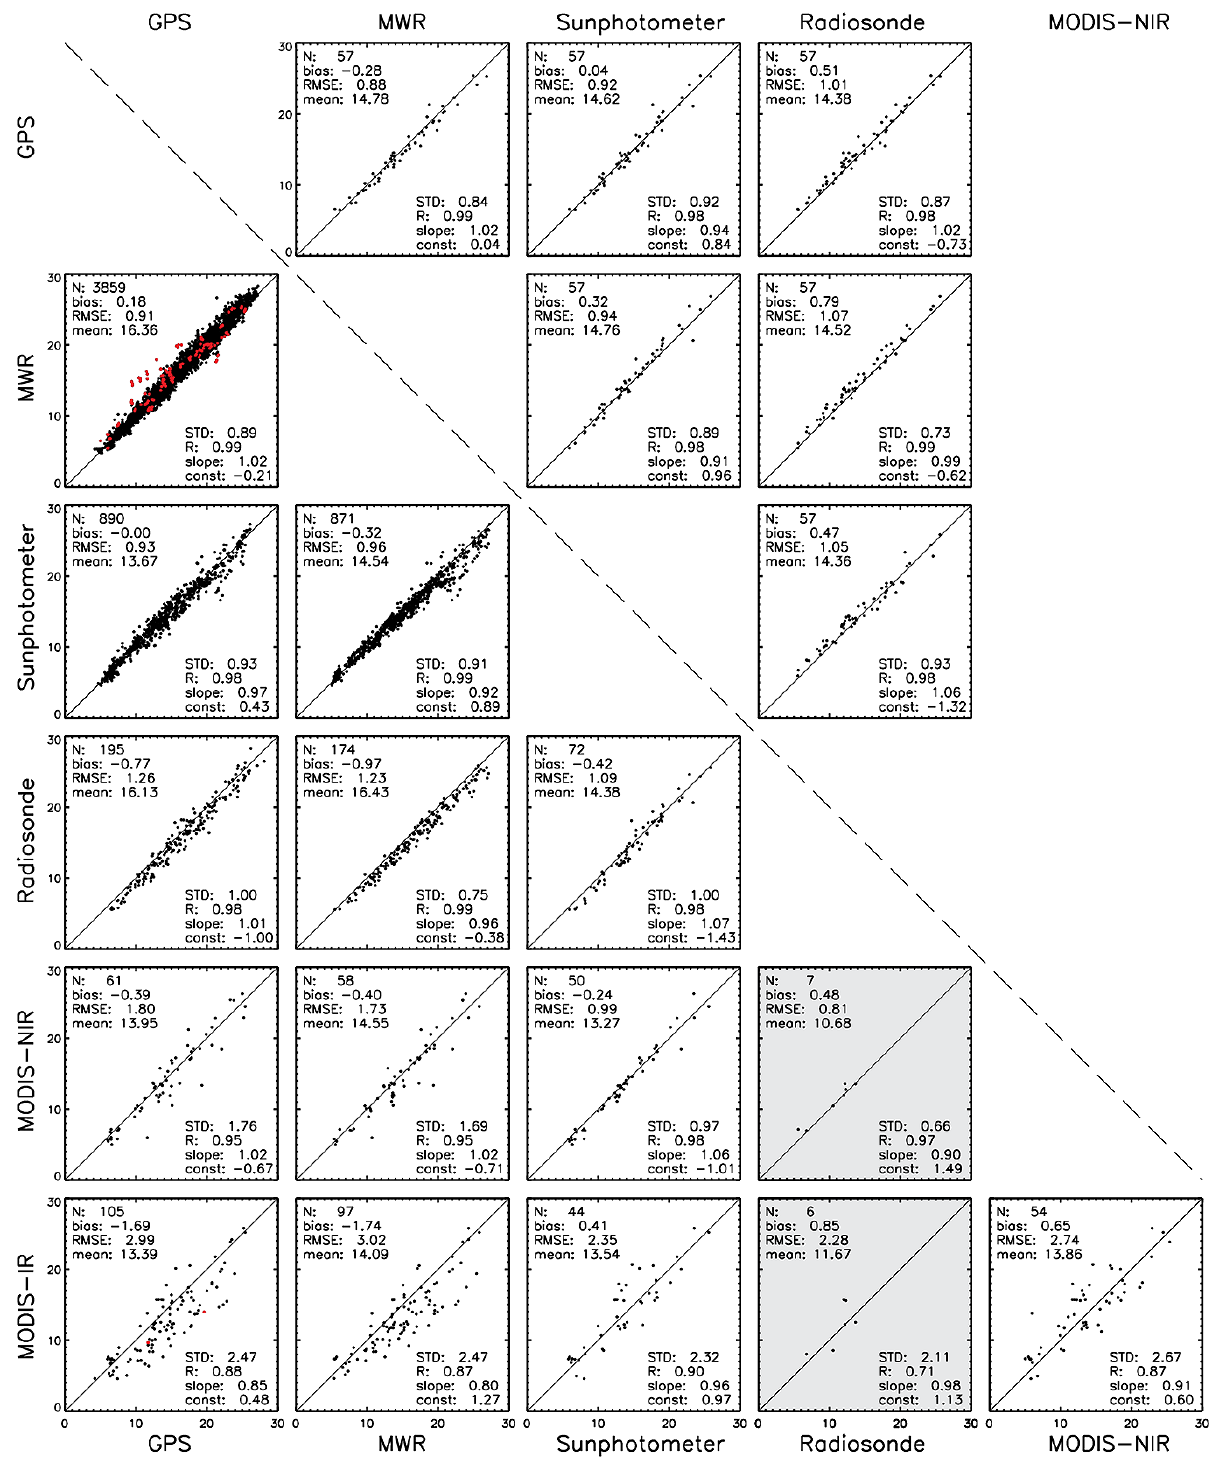
Figure 6. Scatterplots of IWV for all instruments against each other. Included are the number of measurements ( N ), bias (row–column in kgm − 2 ), root mean square error (RMSE in kgm − 2 ), mean (in kgm − 2 ), standard deviation (STD in kgm − 2 ), Pearson correlation coefficient ( R ), and slope and y intercept (const in kgm − 2 ) of linear regression. The lower left half of the figure shows comparisons when the two instruments measure. The upper right half shows comparisons when all instruments measure. MODIS is not included in the upper half due to less measurements. The GPS measurements between 00:00 and 01:00UTC are highlighted in